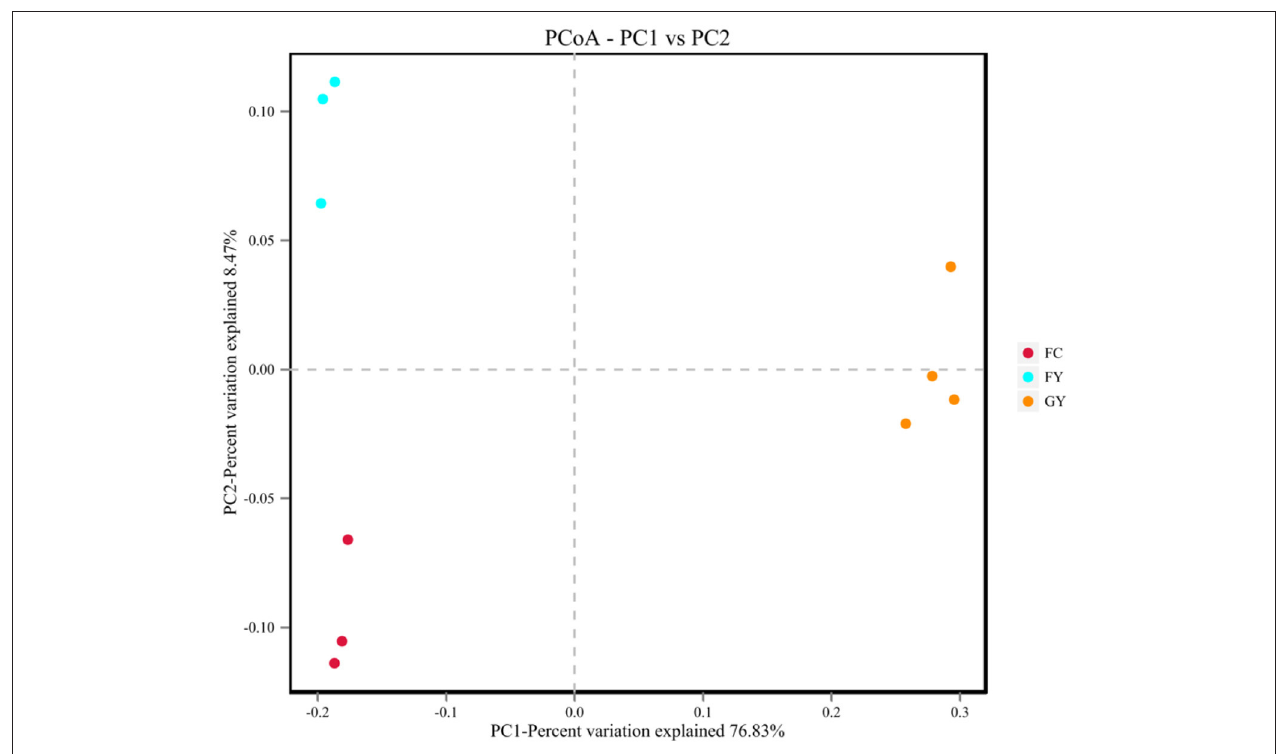
FIGURE 4 | Principal coordinates analysis (PCoA) of rumen bacteria of GYs, FC, and